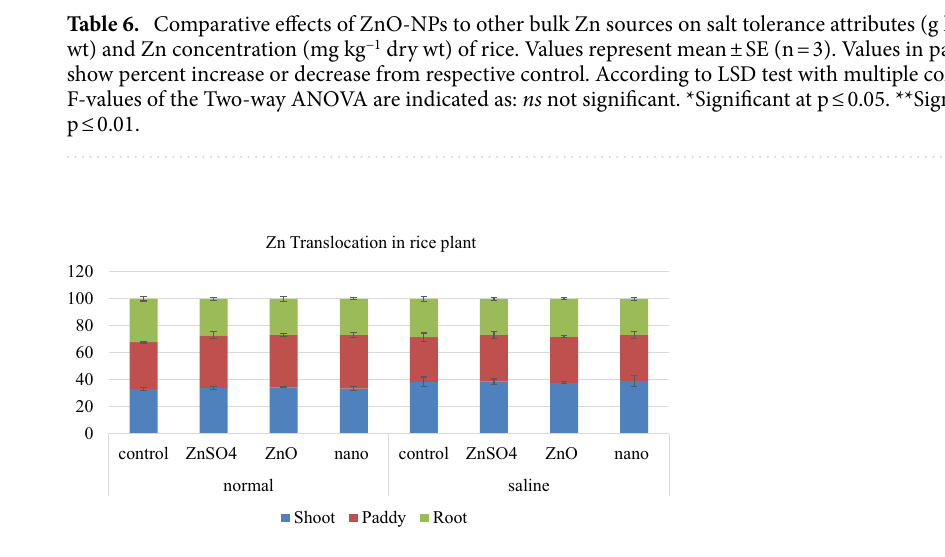
Figure 5. Percentage distribution of Zn translocated in different plant parts of rice at maturity (Each value is a mean, n = 3 statistically significant at p ≤ 0.05, T bars represent ± standard error of